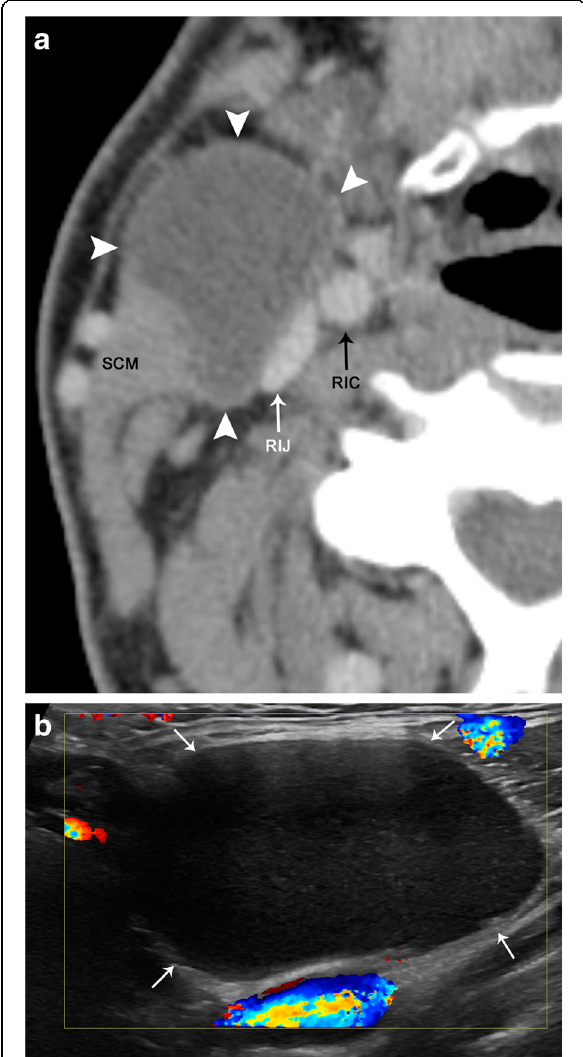
Fig. 23 Second branchial cleft cyst. a Axial contrast-enhanced CT image demonstrates a well-circumscribed and hypoattenuating lesion (arrowheads) along the anterior margin of the right sternocleidomastoid muscle (SCM) and anterolateral to the right carotid space, internal carotid artery (RIC), and internal jugular vein (RIJ). b Color Doppler ultrasound image demonstrates that this lesion (arrows) is hypoechoic with low-level echoes. There is no internal vascularity or peripheral